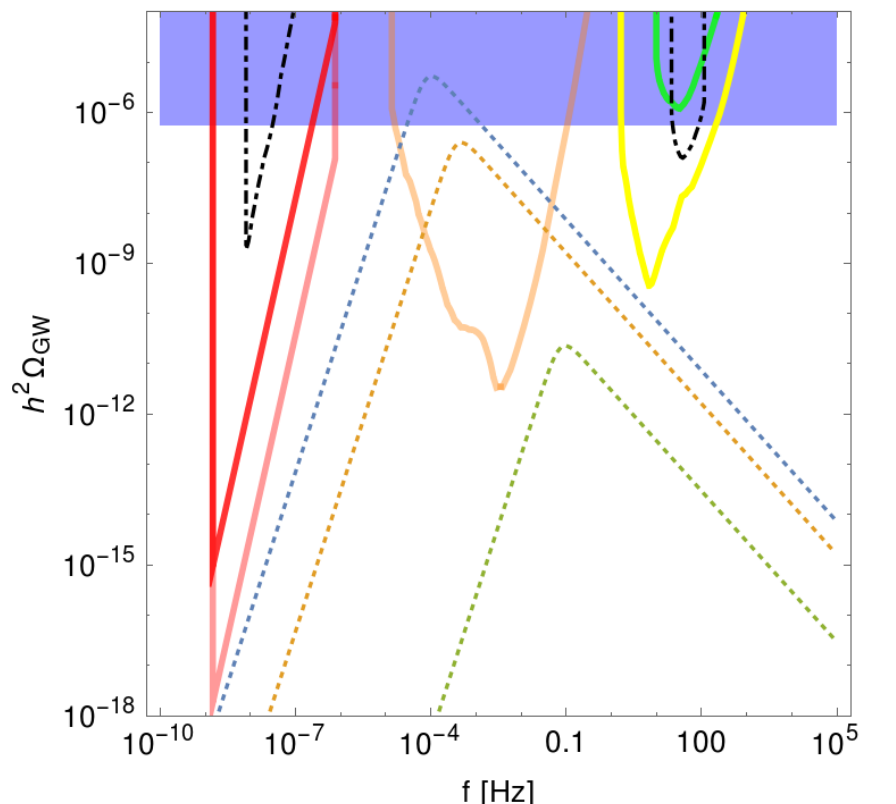
Figure 7 . SGWB signals of the benchmark scenarios B 1 (lower dashed curve), B 2 (middle dashed curve) and B 11 (upper dashed curve), and the current and forthcoming GW experiments able to test them. The dotted-dashed lines correspond to the power-law sensitivity curves h 2 (cid:10) pls of PPTA & EPTA & NANOGRAV (at frequencies f (cid:24) nHz) and aLIGO O1 (at frequencies f (cid:24) 100 Hz); the solid lines correspond to the sensitivity curves (cid:10) sens ( f ) of SKA observing 100 milli-second pulsars (dark red), SKA observing 2000 milli-second pulsars (light red), LISA (orange), aLIGO at its (cid:12)nal design (green) and ET